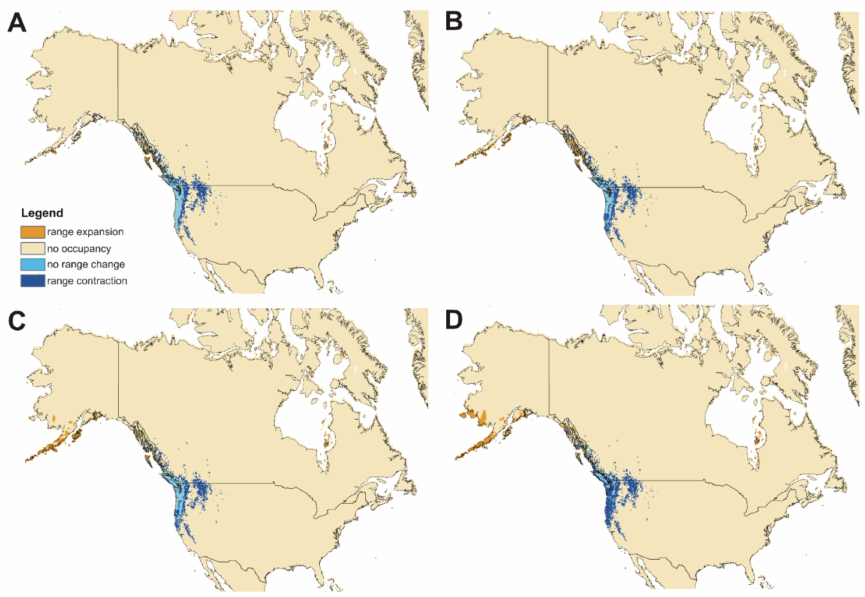
Figure 9. Future changes in the distribution of suitable niches of subsp. puniceus according to